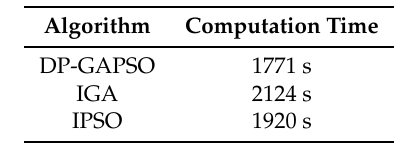
Table 10. The computation times for three optimization algorithms.